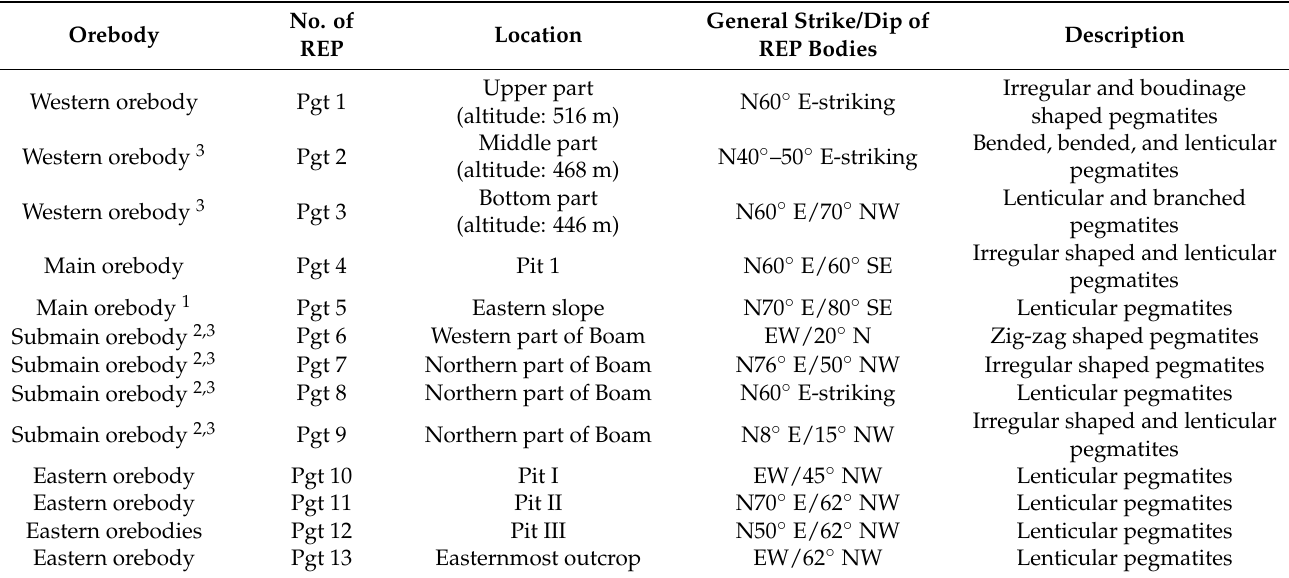
Table 2. Detailed information on the rare-element pegmatites (REPs) investigated in this